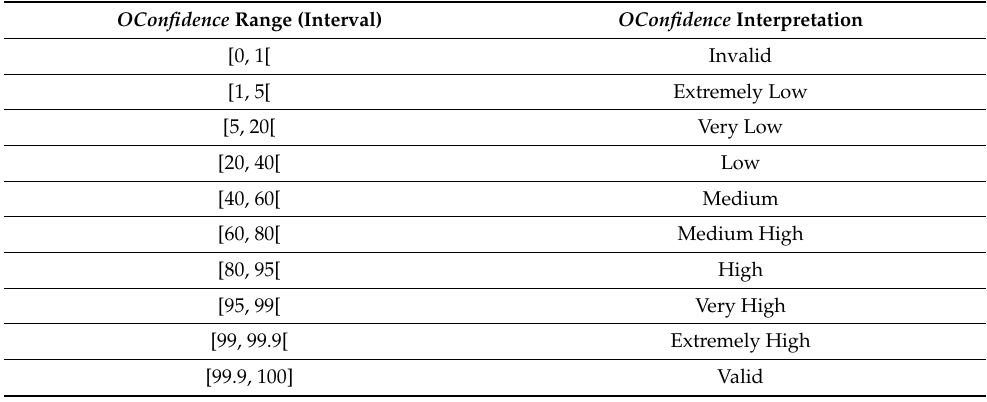
Table 2. Interpretation of the Overall Confidence, from Boaye Belle et al.